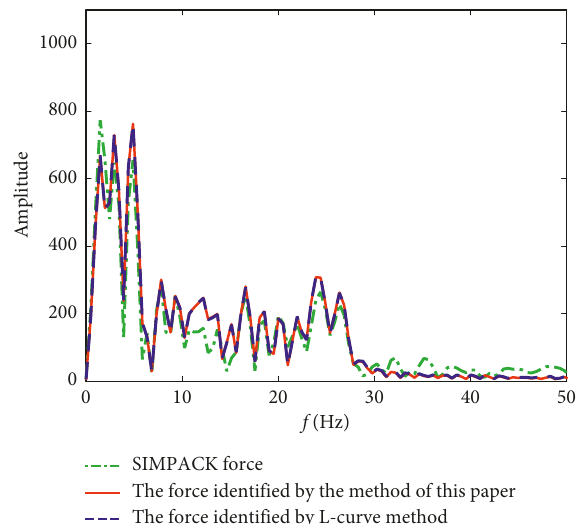
Figure 8: Amplitude-frequency curve of the two methods for F identification when the noise level is 0%. 4